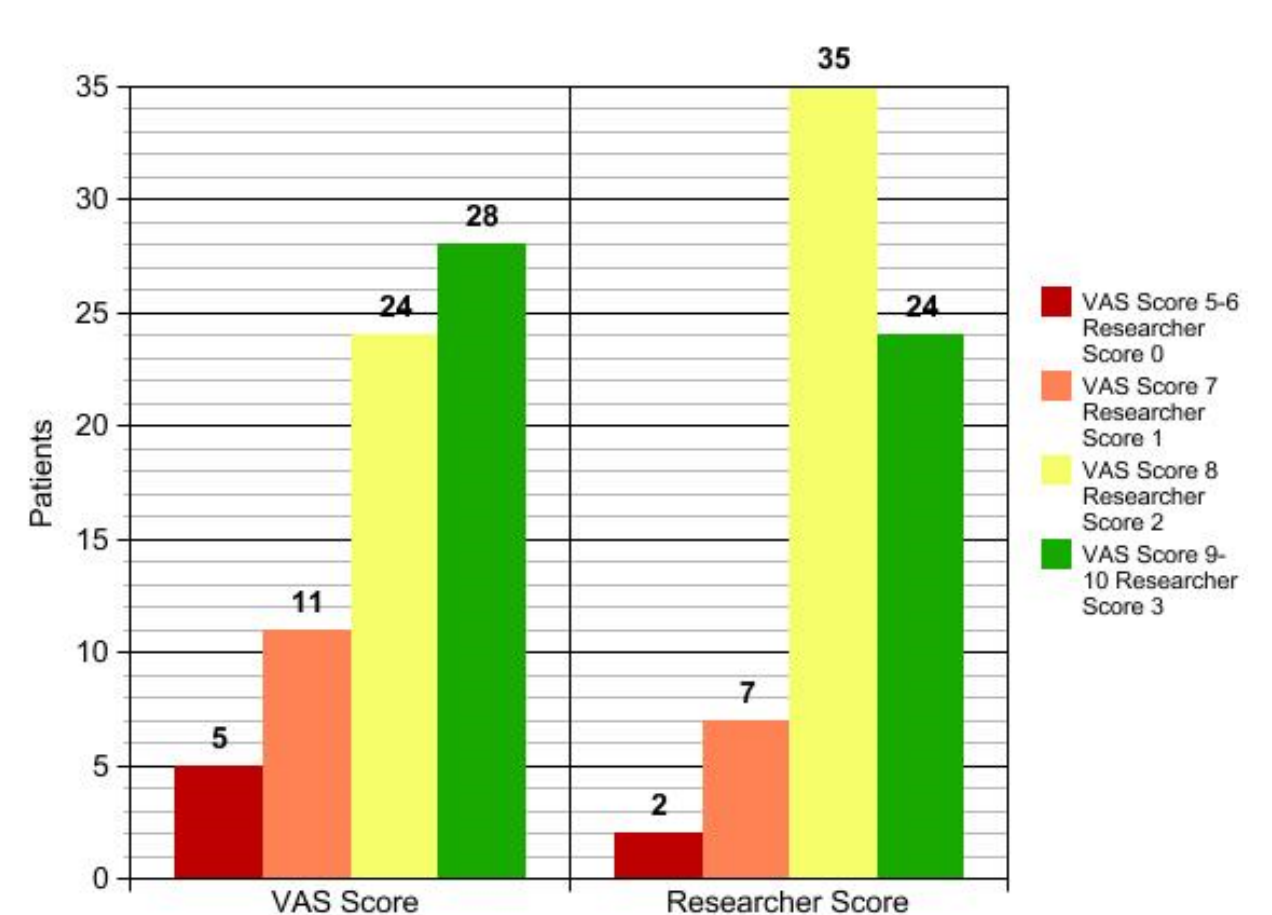
Figure 1. VAS and researcher score.